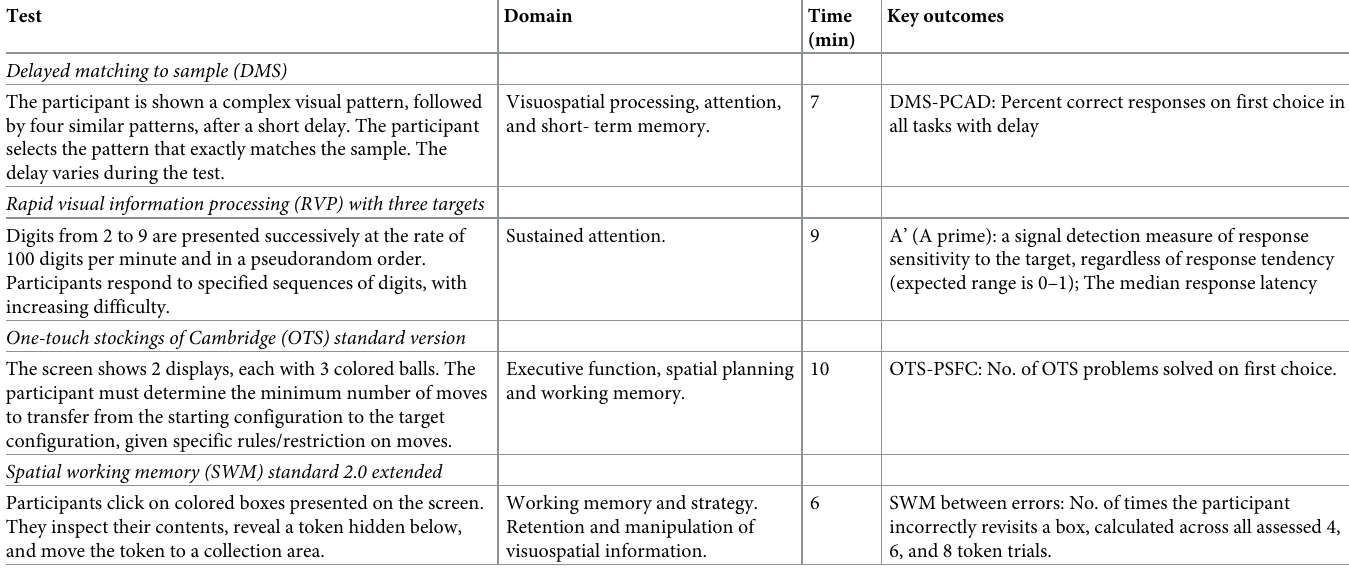
Table 1. Cognitive tests and key outcomes. Test Domain